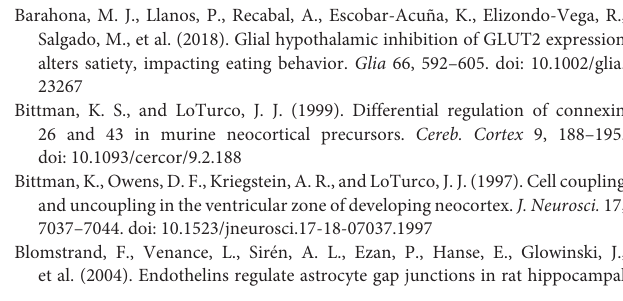
FIGURE S1 | Connexins (Cxs) and Pannexins (Panx) expression. (A,B) Immunohistochemistry of a coronal mouse hypothalamic section (P46) using antibodies to detect Cx45 (white channel) and Vimentin (yellow channel). TOPRO nuclei staining is shown in magenta. (C–J) . High magnification (60 × ) of (A,B) boxes showing Cx45 expression in α - (C–F) and β -tanycytes (G–J) . 3V, Third ventricle. ME, Median Eminence. Scale bar: 50 µ m. (K) Expression of Cx43, Cx45, Panx1 and Panx2 was measured by RT-qPCR in primary cultures of rat tanycytes (P1, N = 3, 4, 5 and 5 independent primary cultures for Cx43, Cx45, Panx1 and Panx2, respectively). Transcriptional expression was normalized to the cyclophilin housekeeping gene. FIGURE S2 | Length of biocytin spread and membrane potential of WT, Cx30 KO and dKO α -tanycytes. (A) Spread of biocytin along the lateral wall measured in micrometers ( µ m). (B) No significant differences were observed between the wild type ( − 74.1 ± 0.7 mV), Cx30 KO ( − 74.7 ± 0.5 mV) and dKO ( − 71.2 ± 3.7 mV) α -tanycyte membrane potential. ( N = 5 animals over 38 days old and at least 12 slices of each genotype; data are represented as means ± SEM; P <